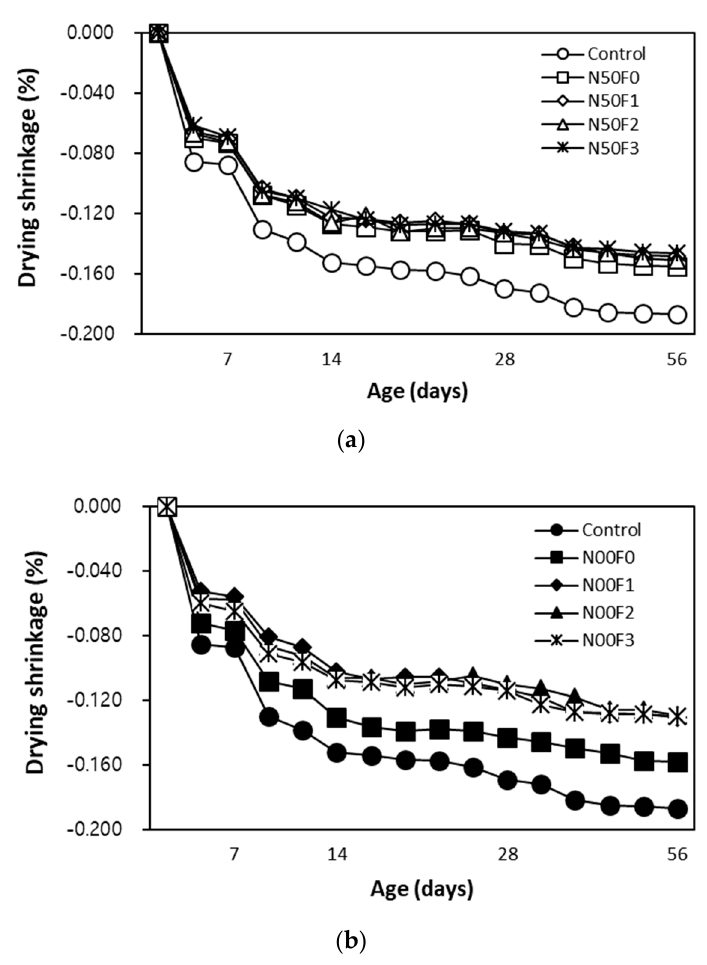
Figure 9. Drying shrinkage of ( a ) N50 and ( b ) N00 mixtures with 50% natural and 100% steel slag aggregates, respectively, as a function of age.